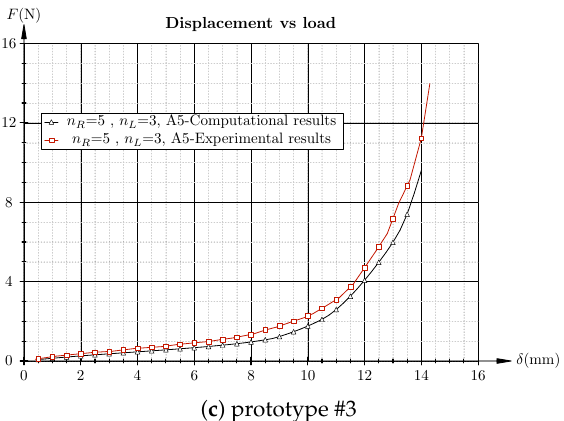
Figure 14. Experimental and computational results: flat plate test of the printed